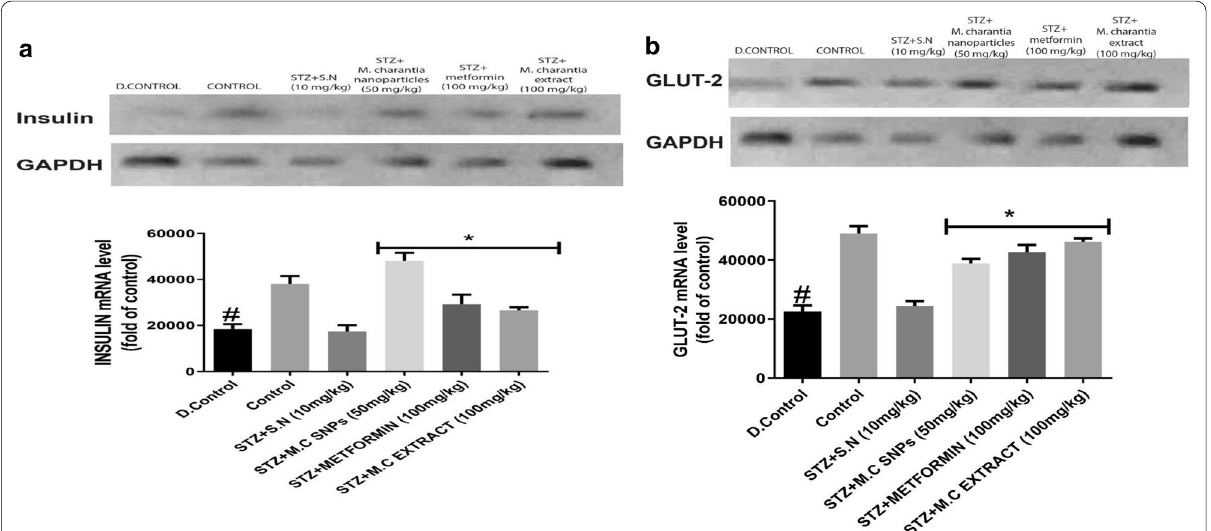
Fig. 5 a snapshot representation of the densitometric evaluation of agarose gel electrophoresis of the reverse transcriptase polymerase chain reaction (RT-PCR) analysis of insulin expression. *represent statistical difference to control ( p < 0.05) while # represent statistical difference to Diabetic control ( p < 0.05). b Snapshot representation of the densitometric evaluation of agarose gel electrophoresis of the reverse transcriptase polymerase chain reaction (RT-PCR) analysis of GLUT-2 expression. *represent statistical difference to control ( p < 0.05) while # represent statistical difference to diabetic control ( p <